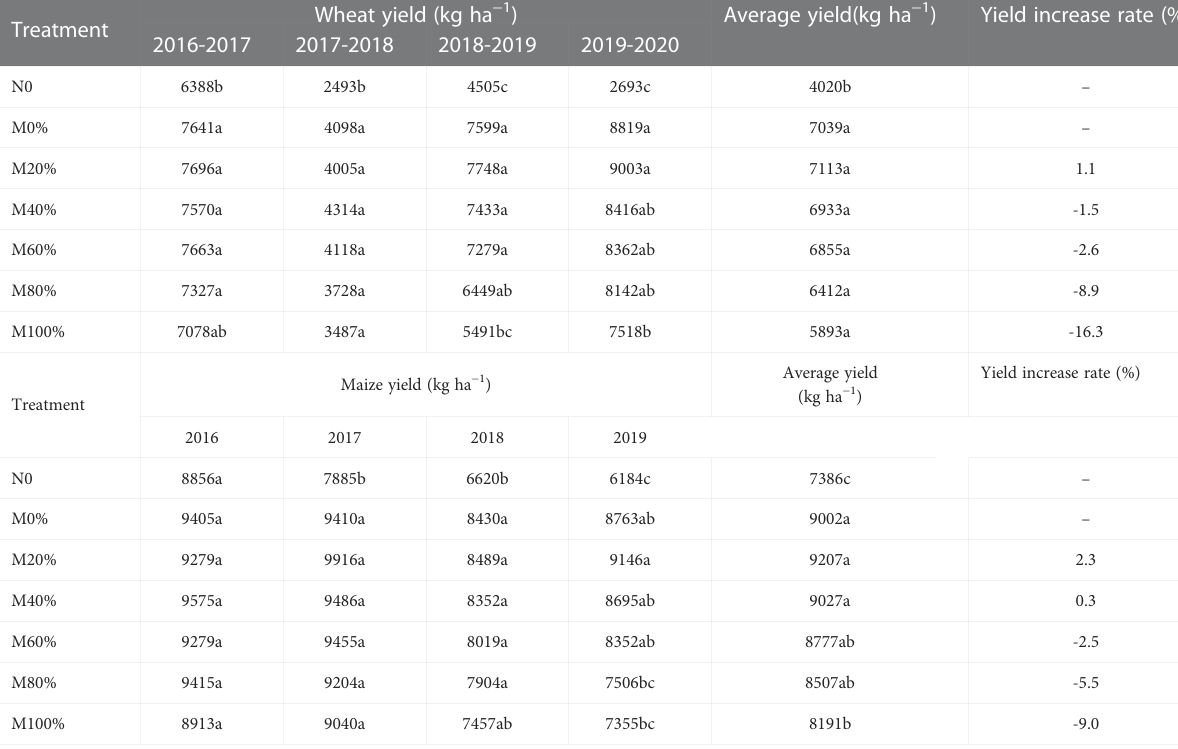
TABLE 1 Yield of wheat and maize under treatments with different ratios of organic substitution for mineral N fertilizer.